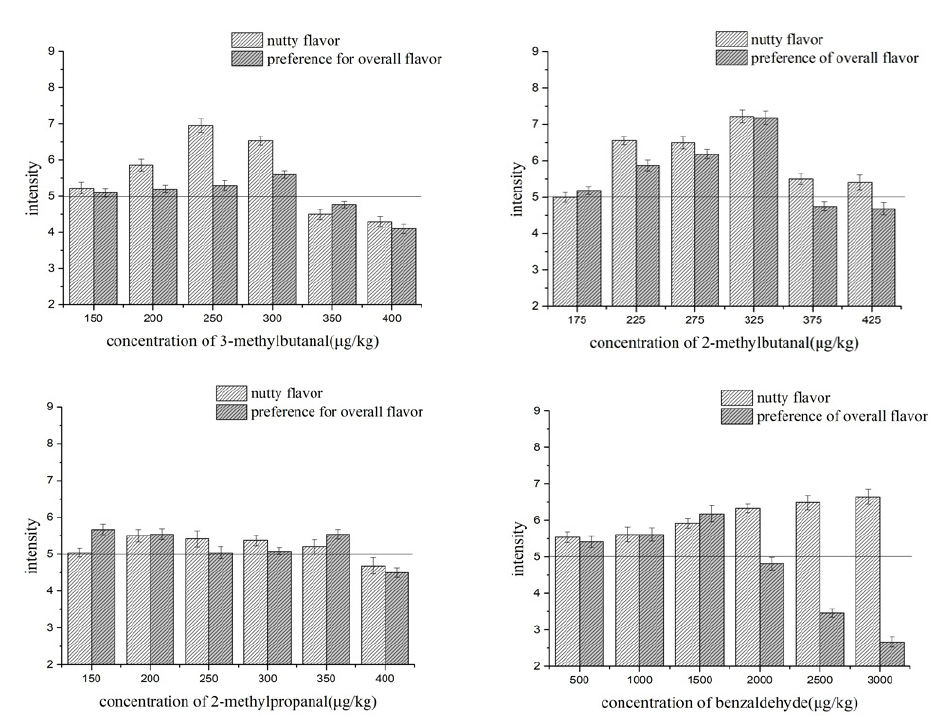
Figure 1. Nutty and overall aroma scores of 3-methylbutanal, 2-methylbutanal, 2-methylpropanal, and benzaldehyde at different concentrations in the cheddar cheese matrix. The horizontal line in the figure indicated the nutty aroma and the overall aroma score was 5, which was regarded as the limit score for acceptable concentration by sensory evaluation.